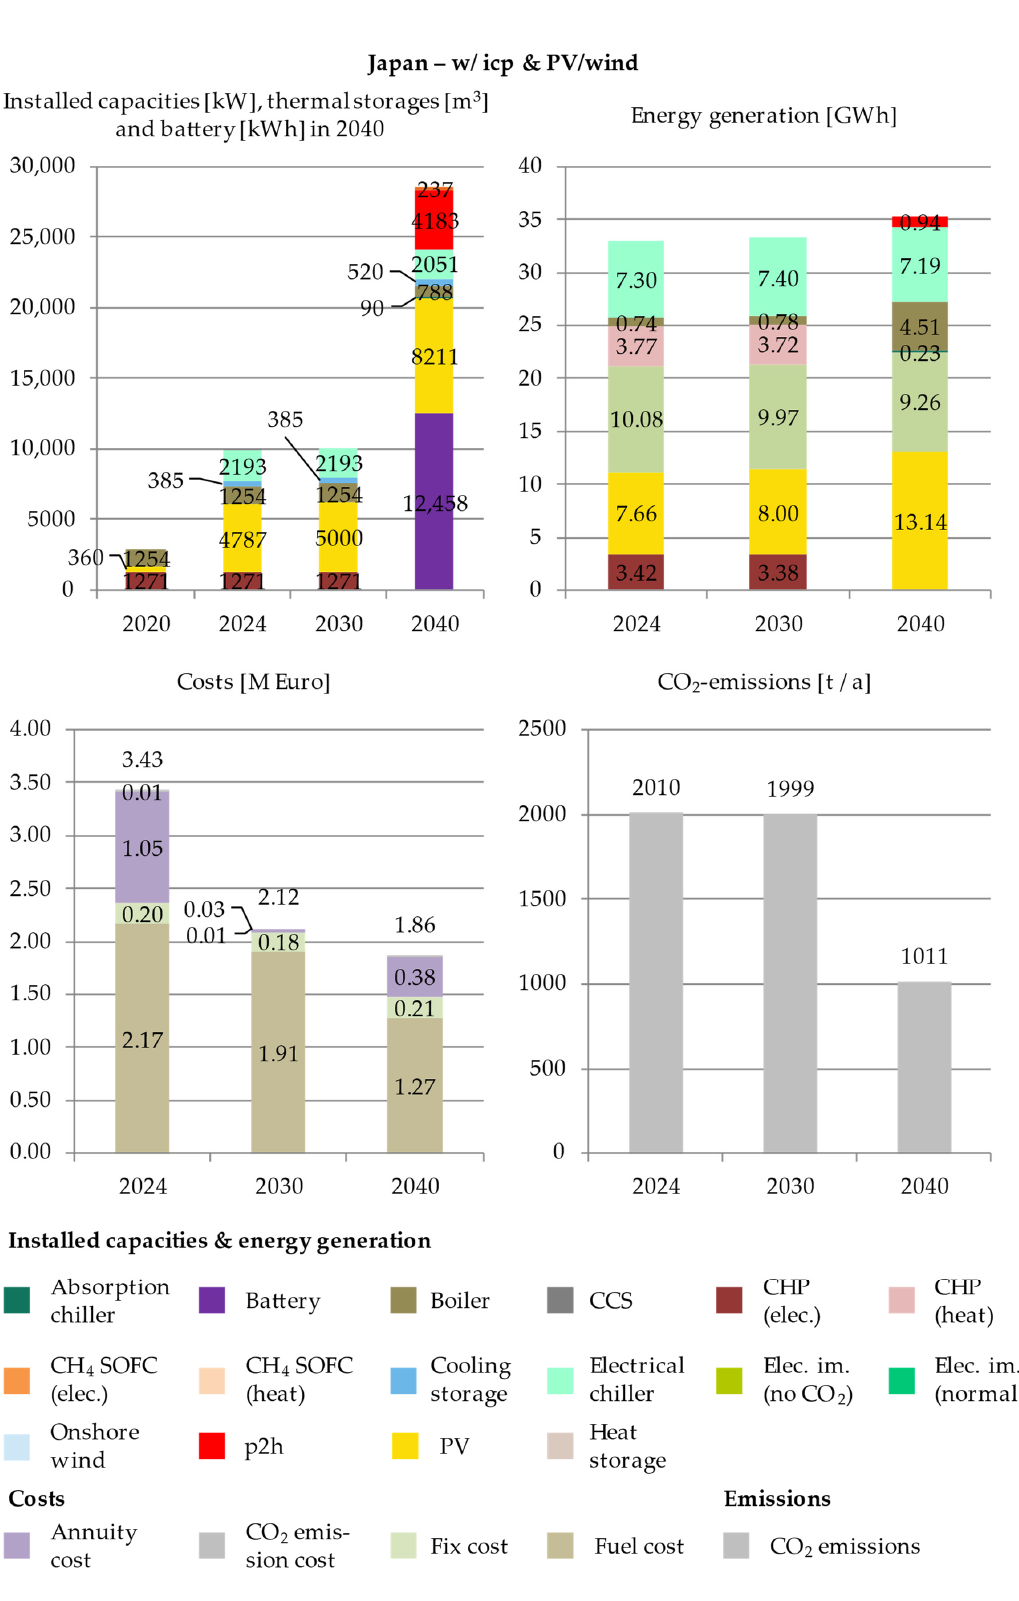
Figure A9. Detailed results for the Japanese “w/ICP and PV/wind” scenario.